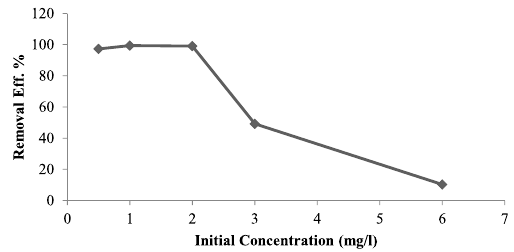
Fig. 5. Effect of concentrations of Kerosene on its degradation from Klebsiella pneumonia